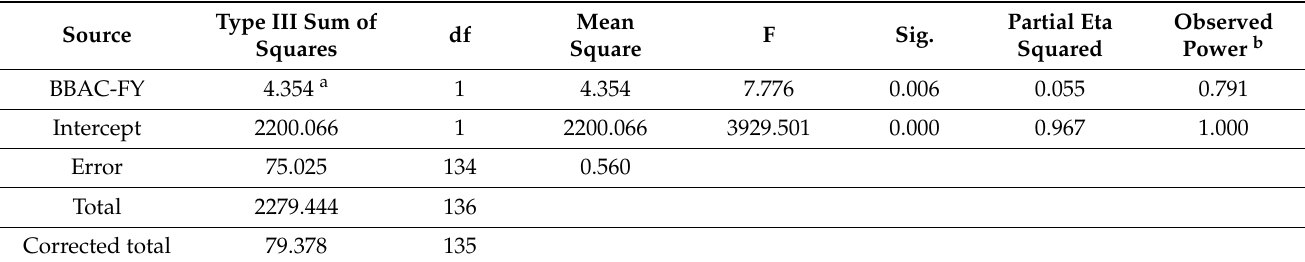
Table 1. Satisfaction differences among picture books.